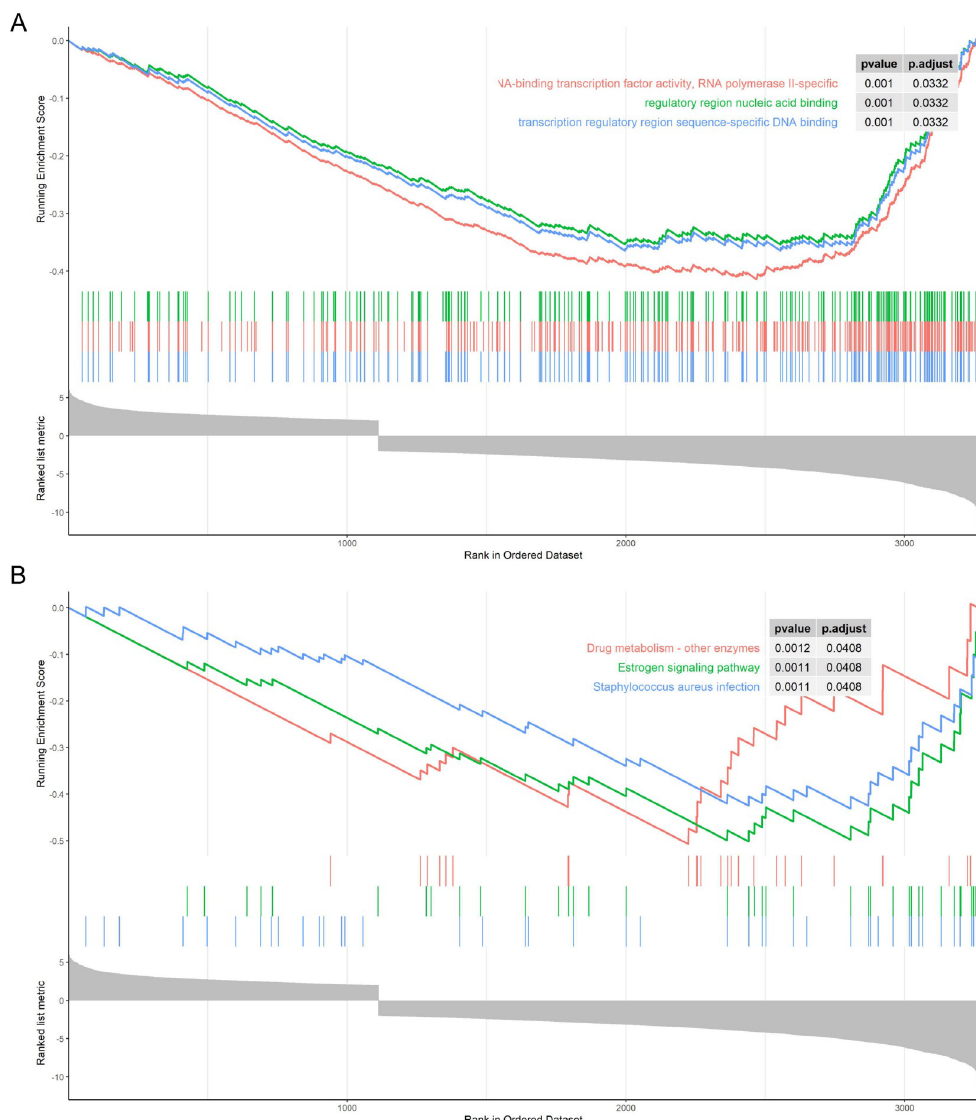
Fig 8. GESA in GO term and KEGG pathway. A. GSEA in GO term. B. GSEA in KEGG